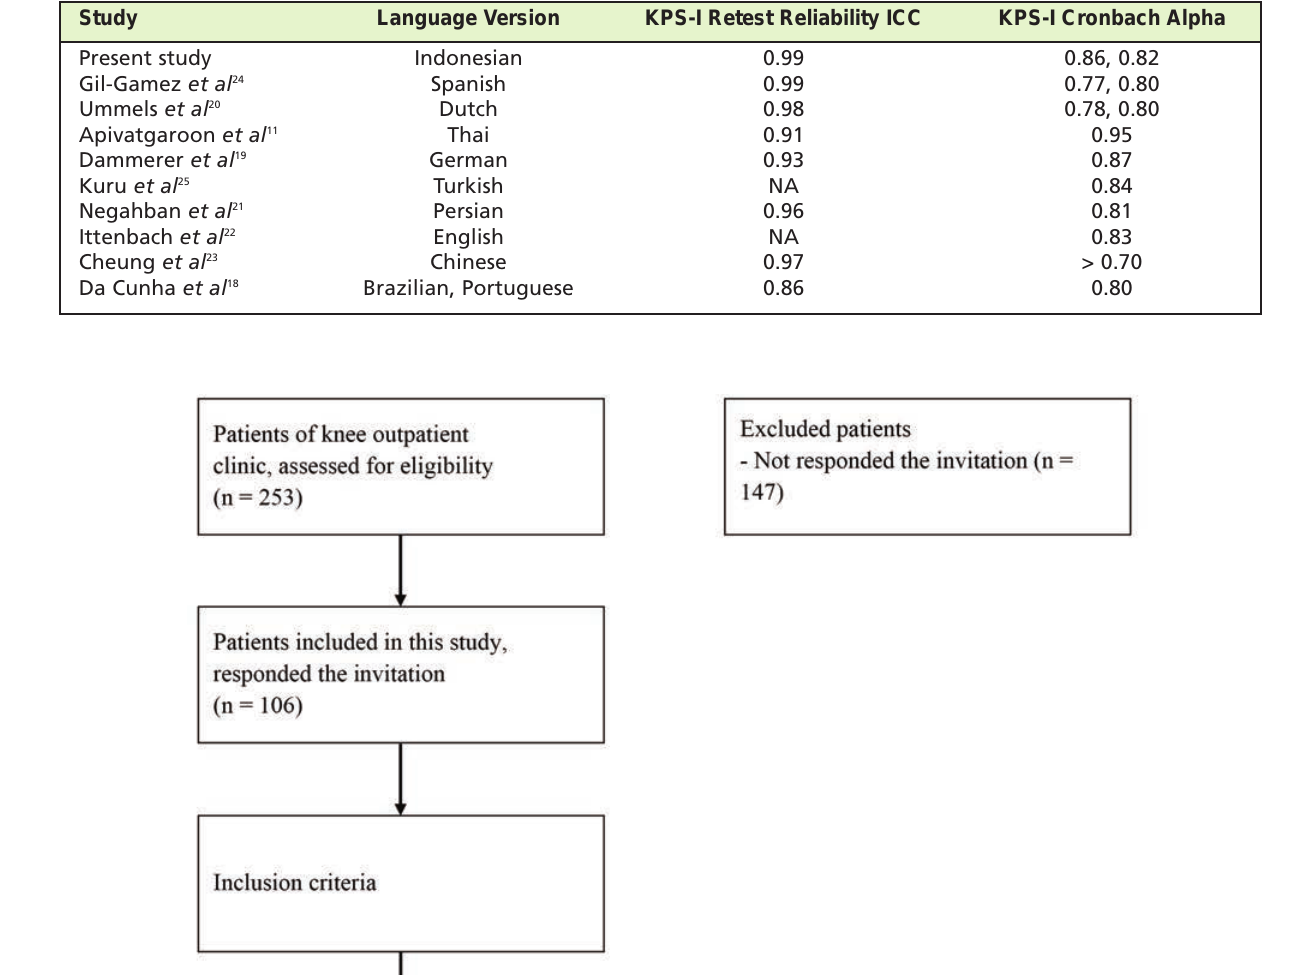
Psychometric Properties of Kujala Score Including KPS-I Table V: